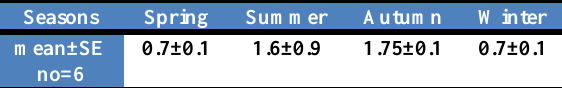
Table, 1: Testosterone hormone level (ng/ml) during different seasons in dog.